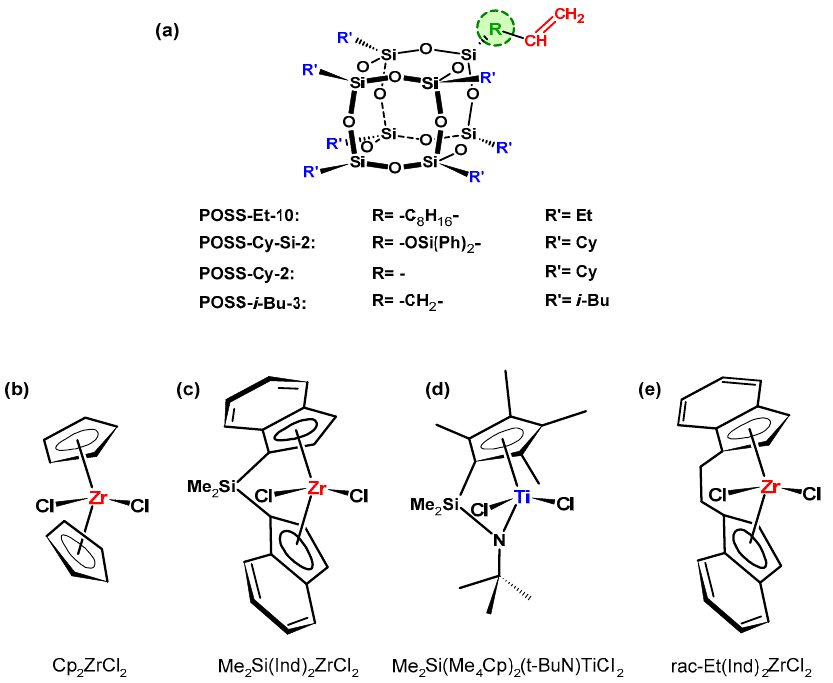
Figure 5. Structure of monoalkenylsilesquioxane comonomers ( a ) copolymerized with ethylene over metallocene catalysis systems ( b – e ) [68–70].